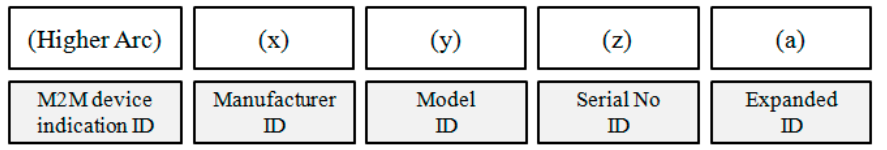
Figure 2. oneM2M standard object identifiers (OID).